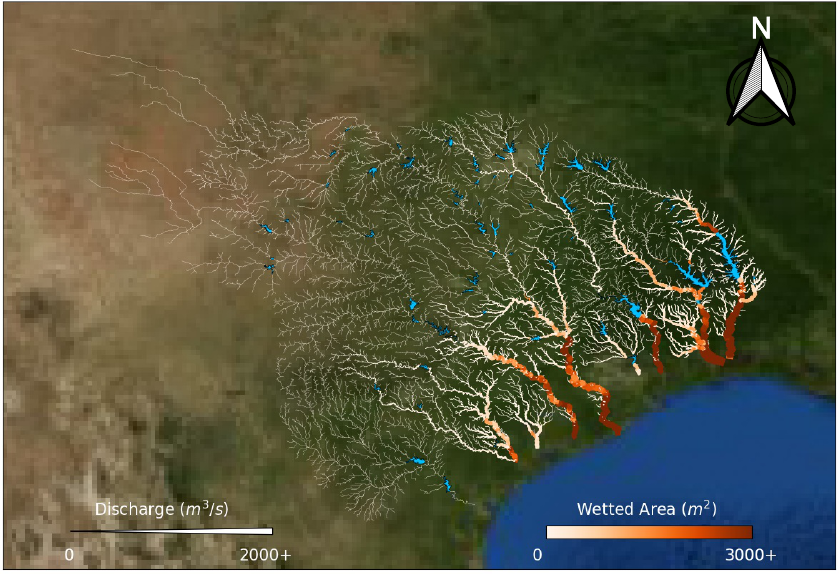
Figure 14. Steady SVEs simulation result on 1 September 2017 in Texas–Gulf